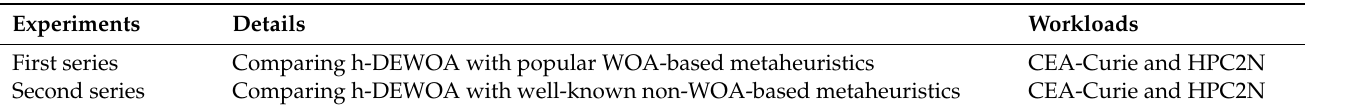
Table 7. Comparative experimental plan.